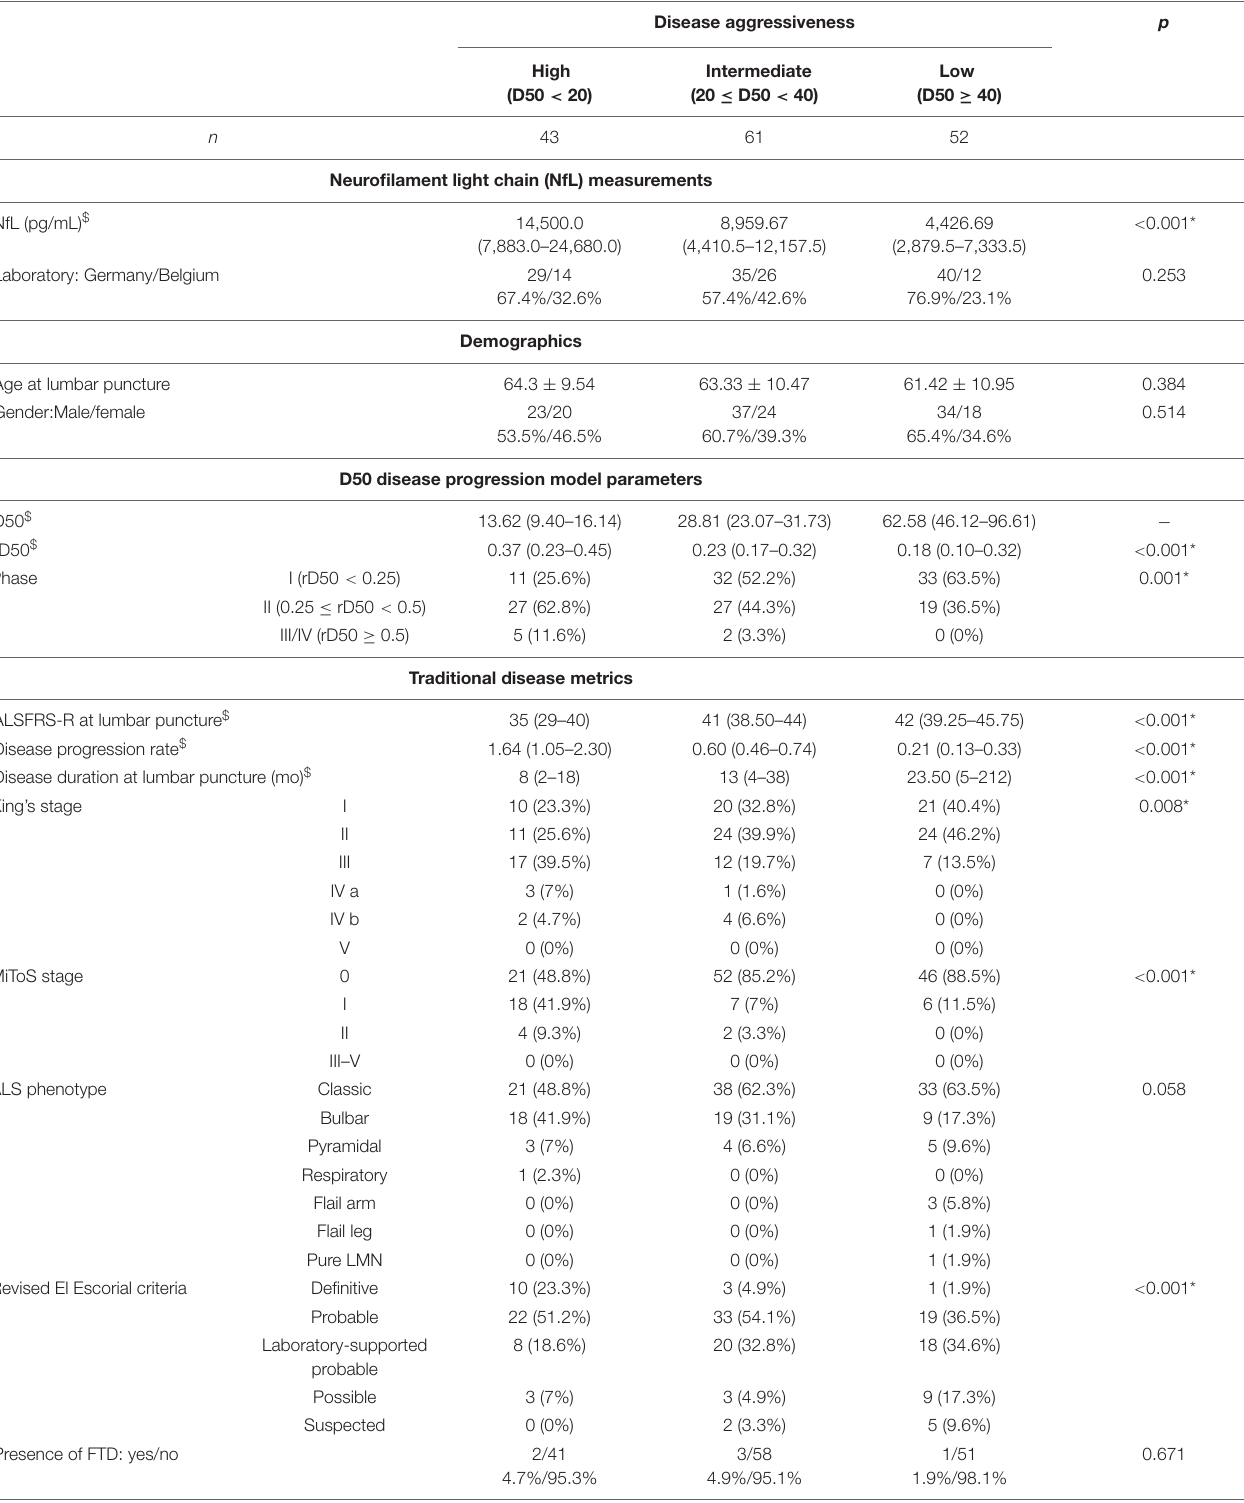
TABLE 1 | Demographic and clinical data for patients with ALS ( n =